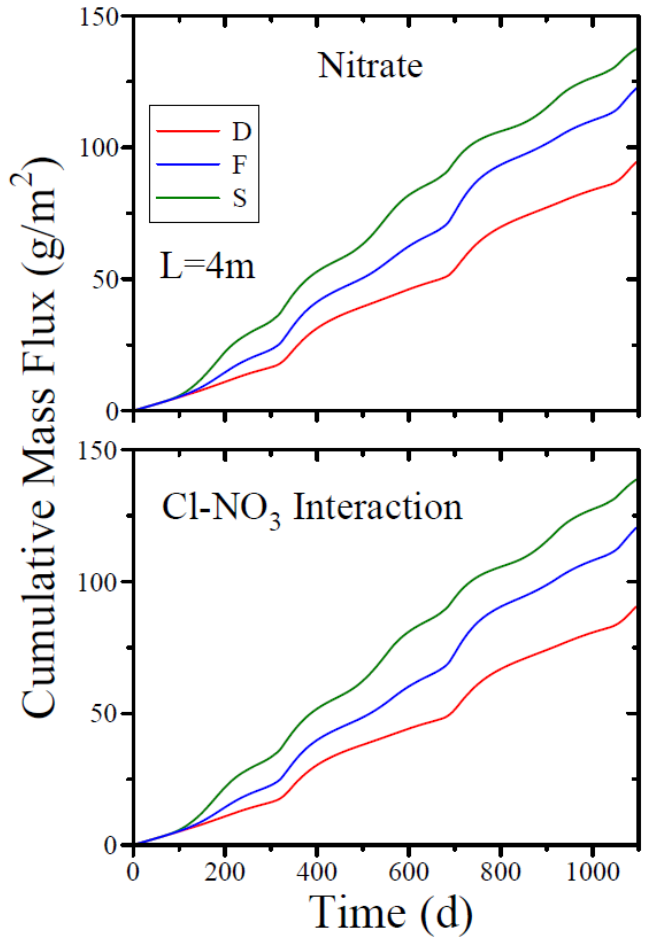
Figure 10. Cumulative mass fluxes of nitrate crossing a horizontal CP located at soil depth, L = 4 m, for the different scenarios examined. Top panel — the effect of the chloride on N uptake and nitrification was disregarded.